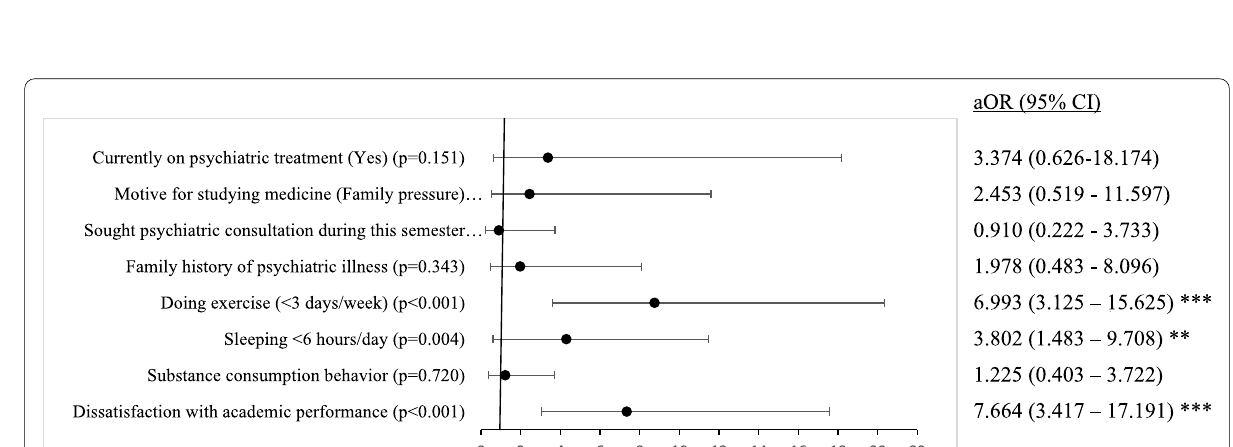
SD Standard deviation, SE Standard error